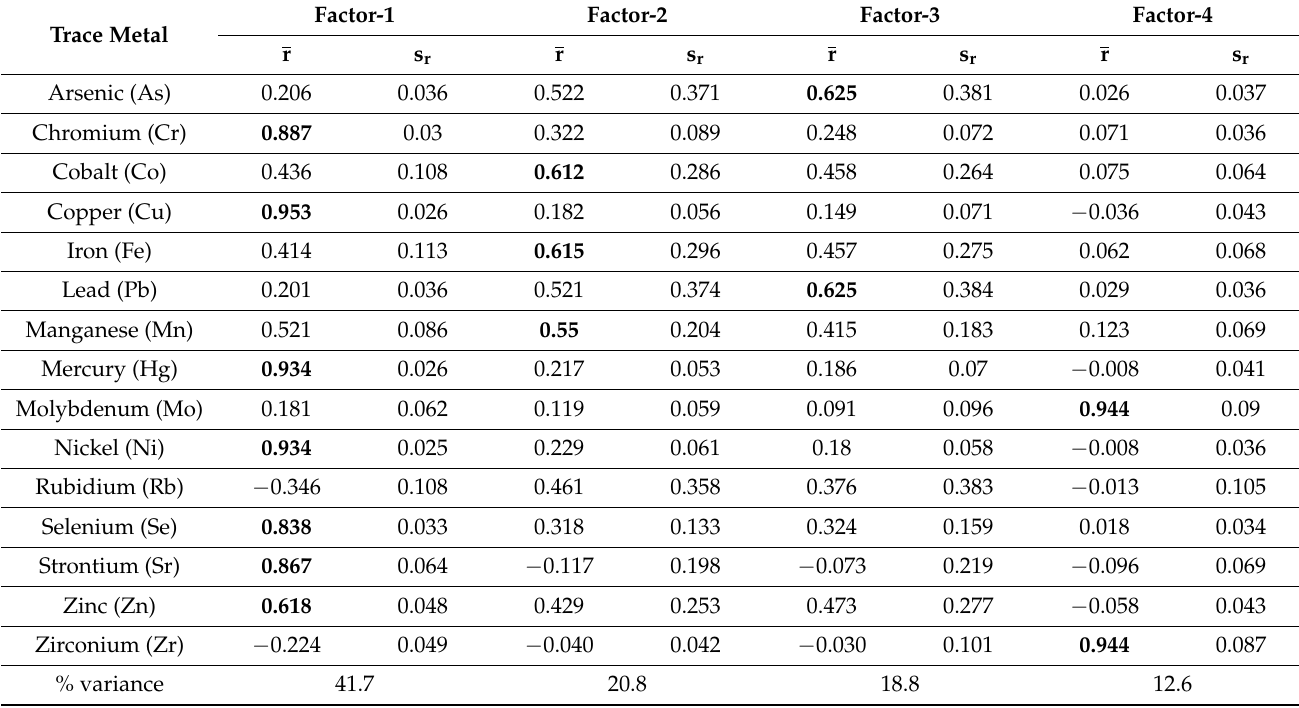
Table 6. Resampled Syracuse trace metal analytical measurement error varimax-rotated factor dimensions: census tract averaged soil sample data (10,000